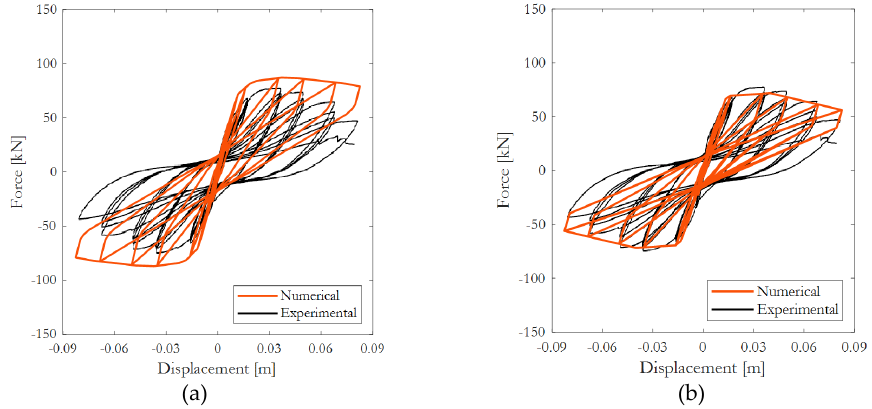
Figure 7. Numerical versus experimental results of the GLD specimen by Verderame et al. [7] for ( a ) modelling option 1 (rigid beam-column joints) and (b ) modelling option 2 (with shear springs).